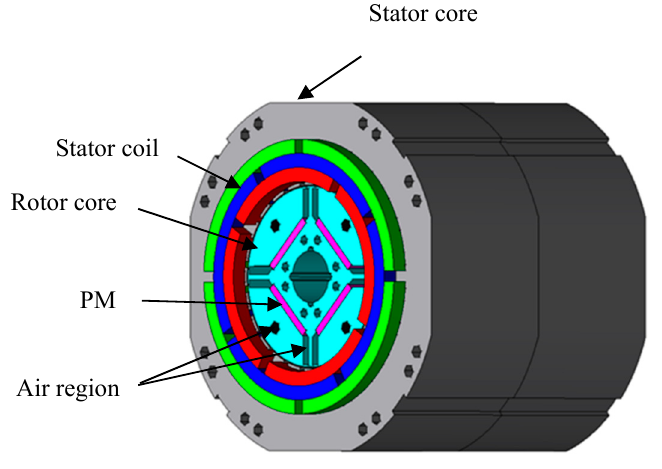
Figure 10. Experimental IPMSM.